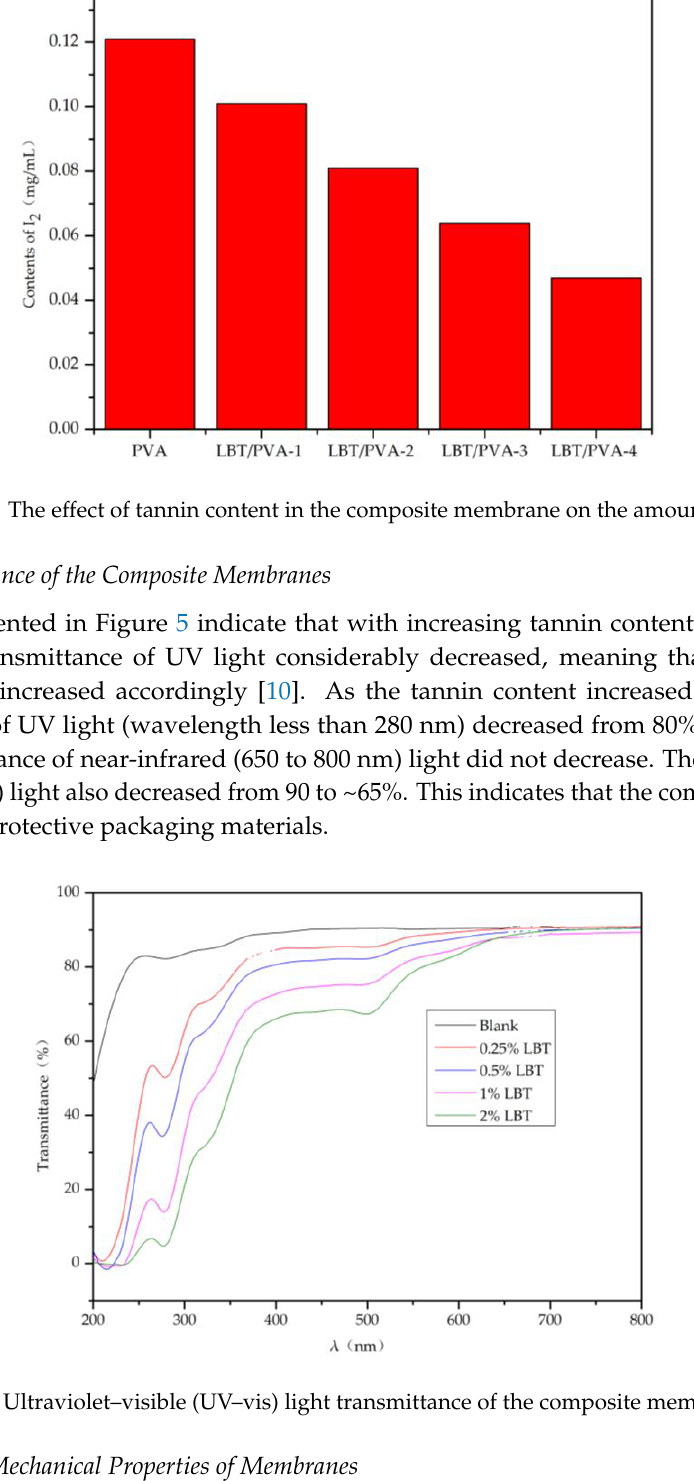
Figure 5. Ultraviolet–visible (UV–vis) light transmittance of the composite membranes.